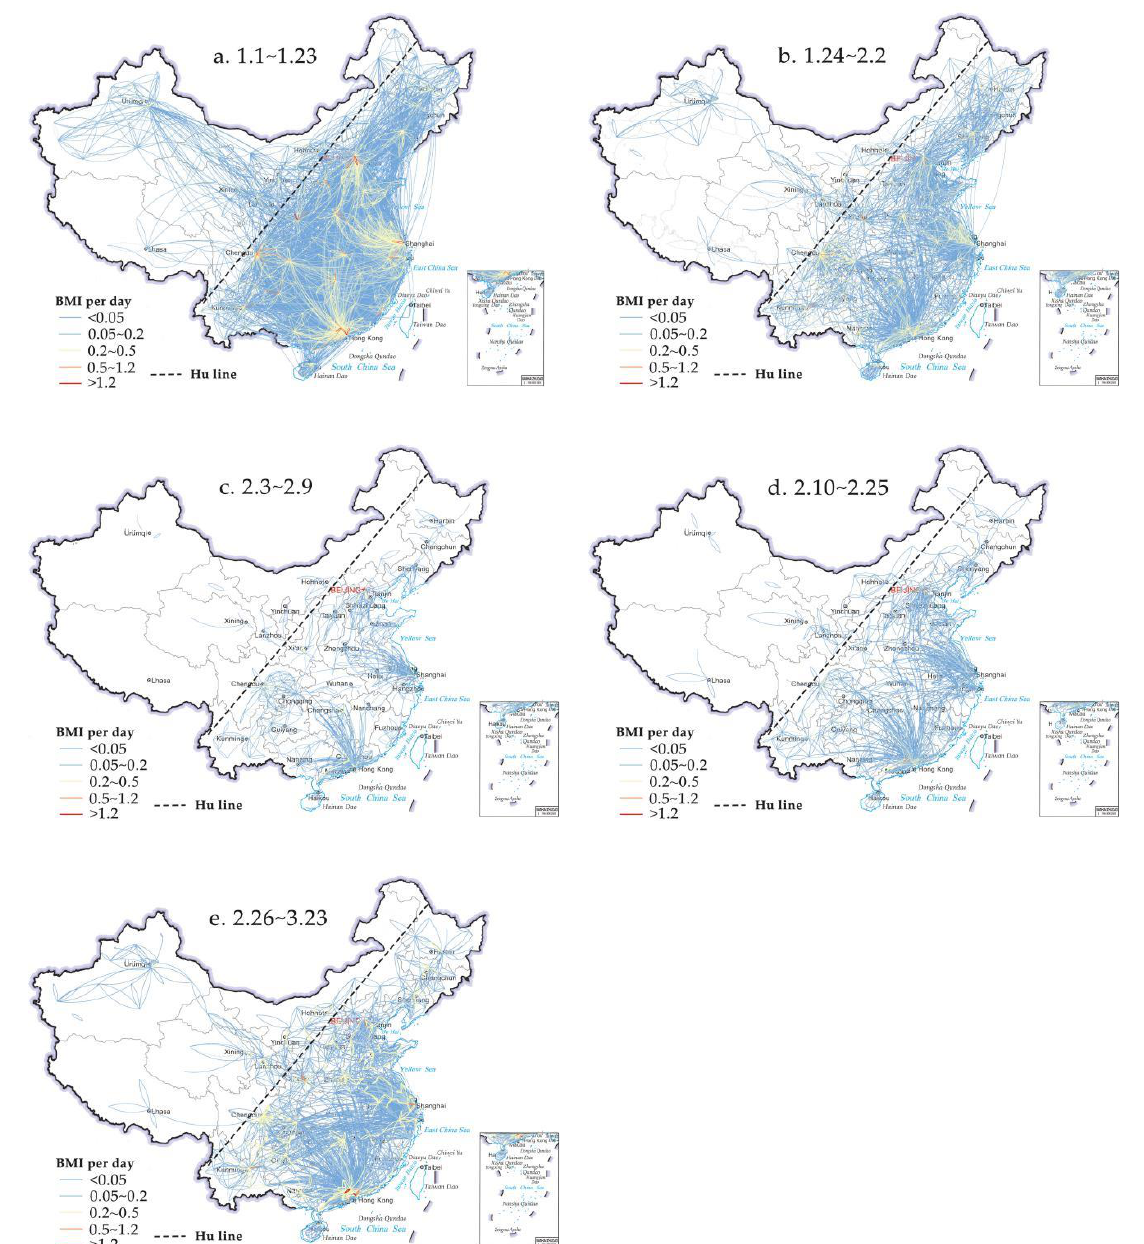
Figure 3. Spatial pattern evolution of PFN in China. Note: due to the asymmetric direction of the villages in PFN, there are two arcs between every two nodes. We set clockwise as the direction of population flow. Baidu Qianxi provide “Baidu migration index (BMI)” to indicate the size of inter-city migration, we convert BMI into the number of population movements using the actual number of inter-city/within-city population flows, provided by official WeChat accounts of Baidu Qianxi. When doing OD network analysis, we need to delete some unimportant links to intuitively and clearly present the information in this figure, so we take BMI equal to 0.003, that is, the actual migrant population is 100 (the rounded data) as the research threshold ( a )–( e ).